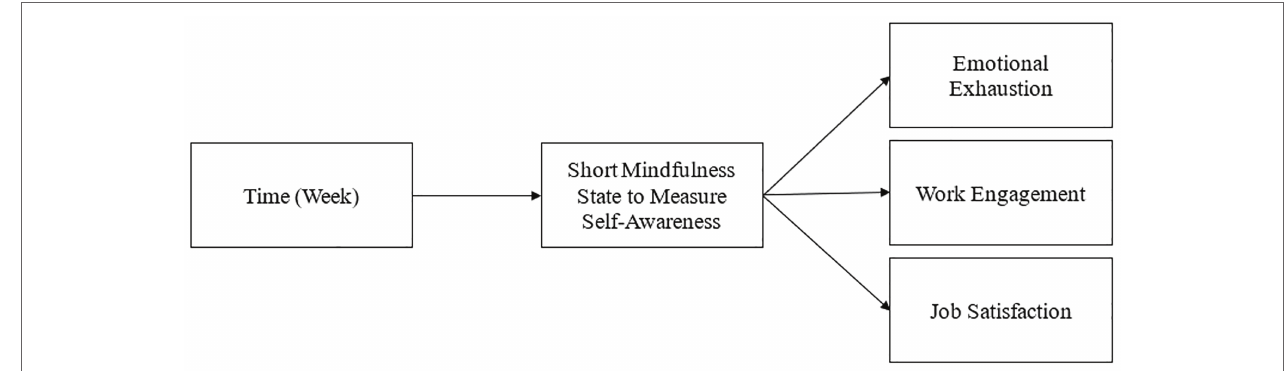
FIGURE 1 | Hypothesized conceptual